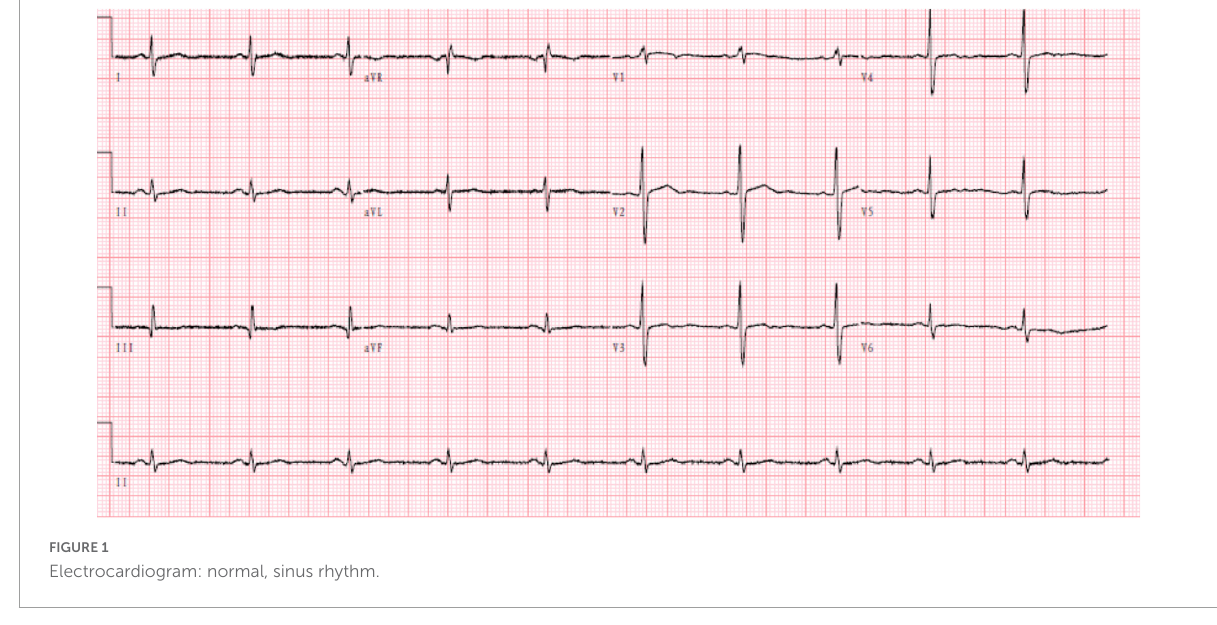
FIGURE1 Electrocardiogram: normal, sinus rhythm.